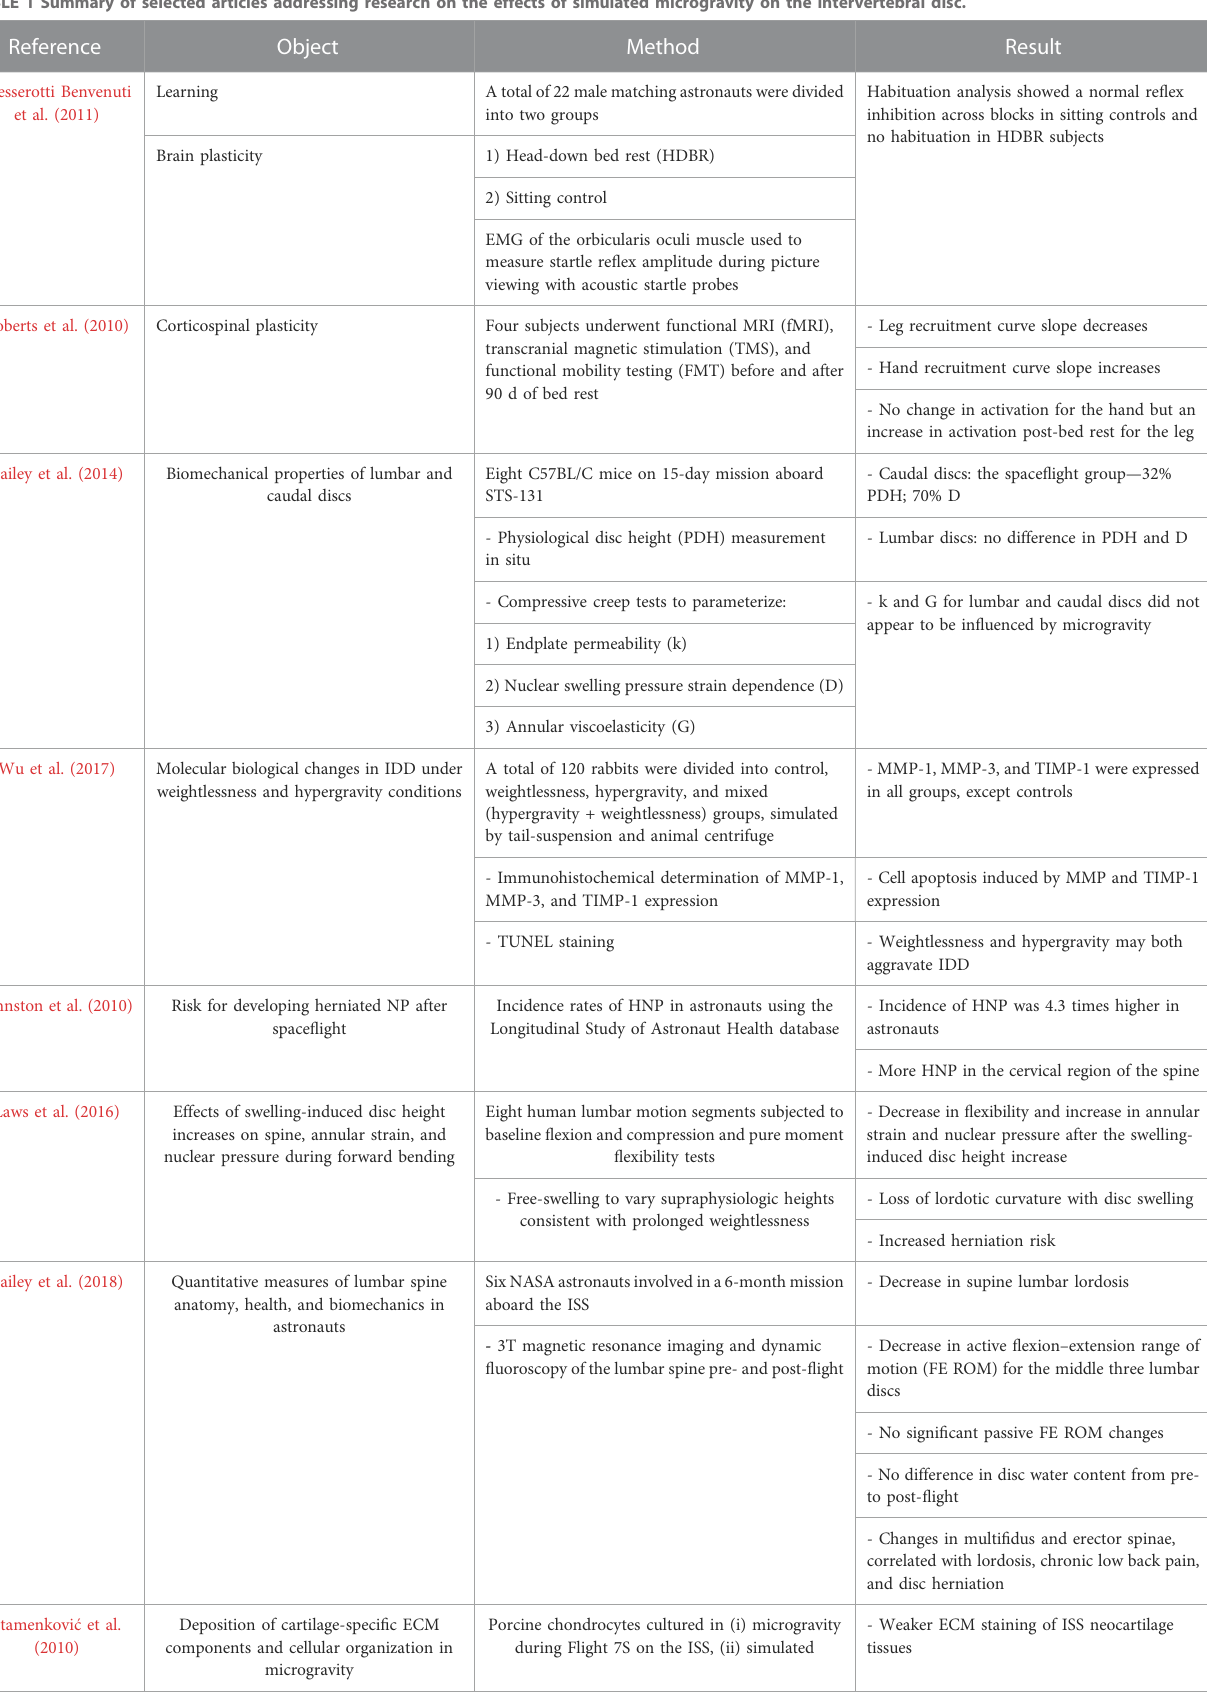
TABLE 1 Summary of selected articles addressing research on the effects of simulated microgravity on the intervertebral